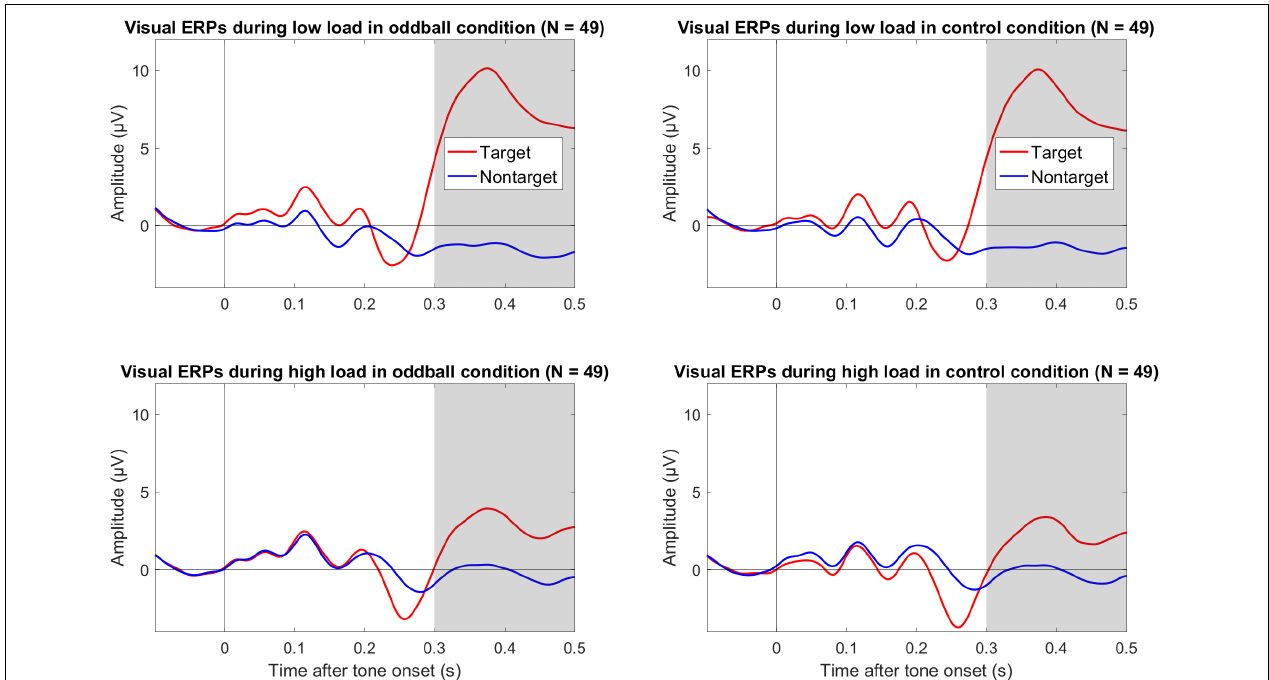
FIGURE 3 | Grand average ( N = 49) ERPs to onset of the visual targets and non-targets in the oddball condition (left column) and the control condition (right column) during low visual load (top row) and high visual load (bottom row) across Cz and Pz. The gray bars mark the relevant intervals for the visual P3. The data were low-pass filtered at 30